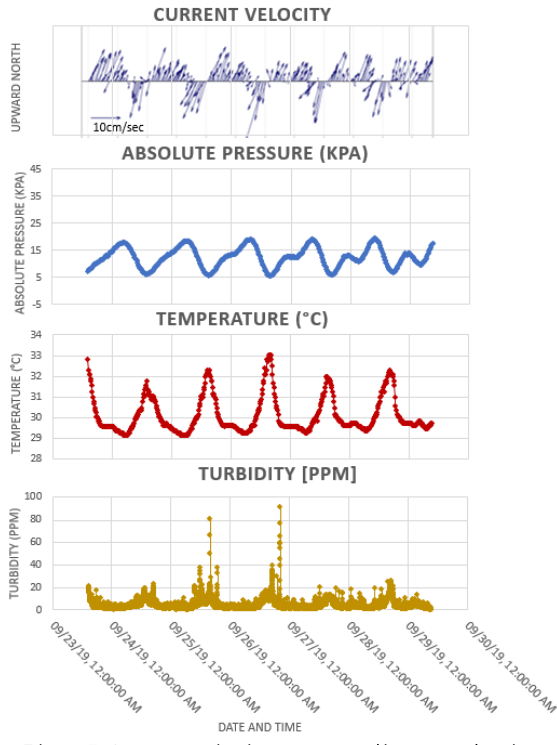
Figure 7. Ocean monitoring sensor readings near the river mouth